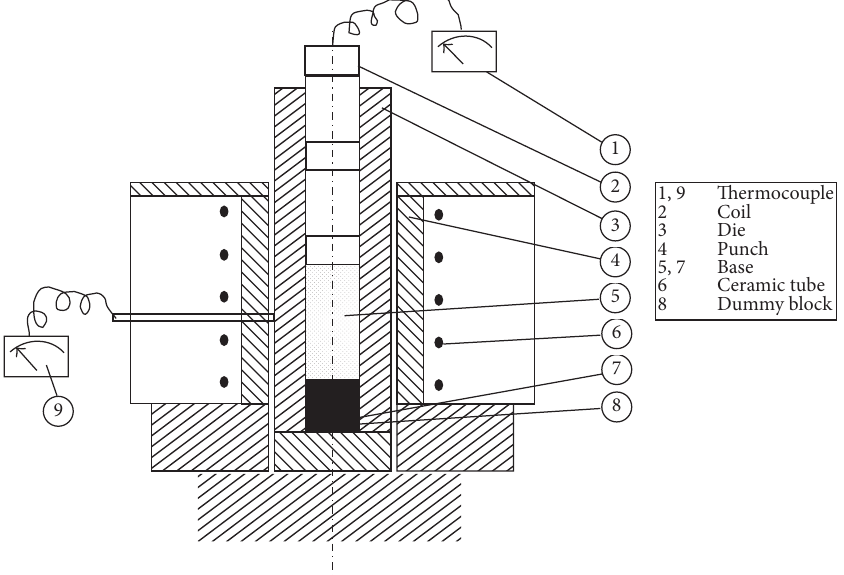
Figure 2: The die setup of the hot pressing